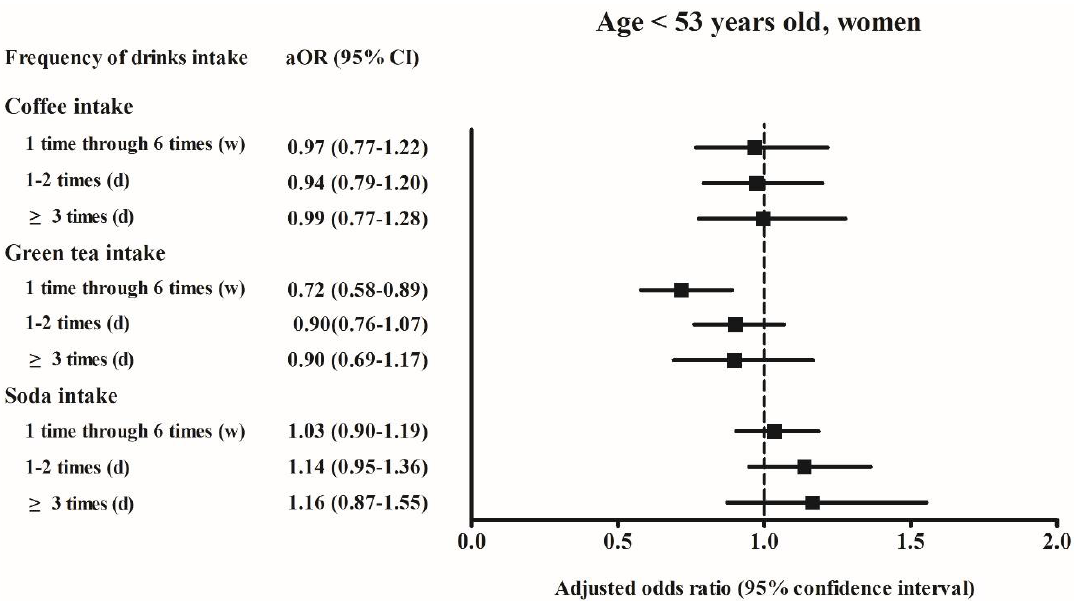
Figure 4. The adjusted odds ratio of the hyperuricemia according to the frequency of coffee/green tea/soda (soft drink) intake in the age < 53 years-old men. Fully-adjusted model (age, BMI, income, past medical histories, smoking, alcohol consumption, nutritional intake, frequency of coffee, green tea, and soft drink intake) was used.